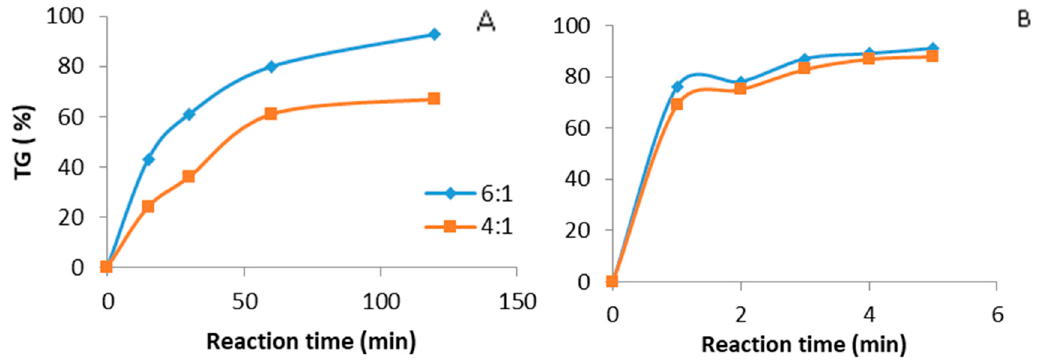
Figure 5. Biodiesel production. Catalyst tetramethyl ammonium hydroxide, 3 wt %, methanol: oil ratio (6:1, 4:1). ( A ) Mechanical stirring batch reactor, temperature 65 °C. ( B ) Ultrasound batch reactor, ultrasound amplitude 60%, temperature 35 °C.